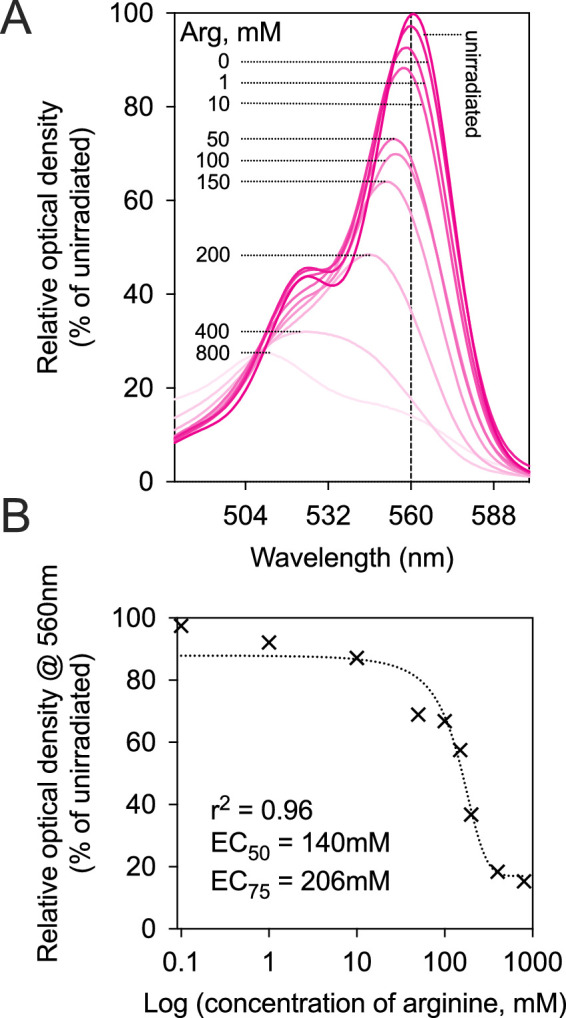
Influence of arg concentration on photobleaching of Rose Bengal in cornea. After staining with 1 mM RB solutions and dehydration with dextran solution, both containing varying concentrations of arg, corneas were irradiated with 8.2 J/cm2 green light in the absence of oxygen. (A) RB absorption spectra before and after irradiation. (B) The RB absorption at 560 nm after 8.2 J/cm2 irradiation versus arg concentration.